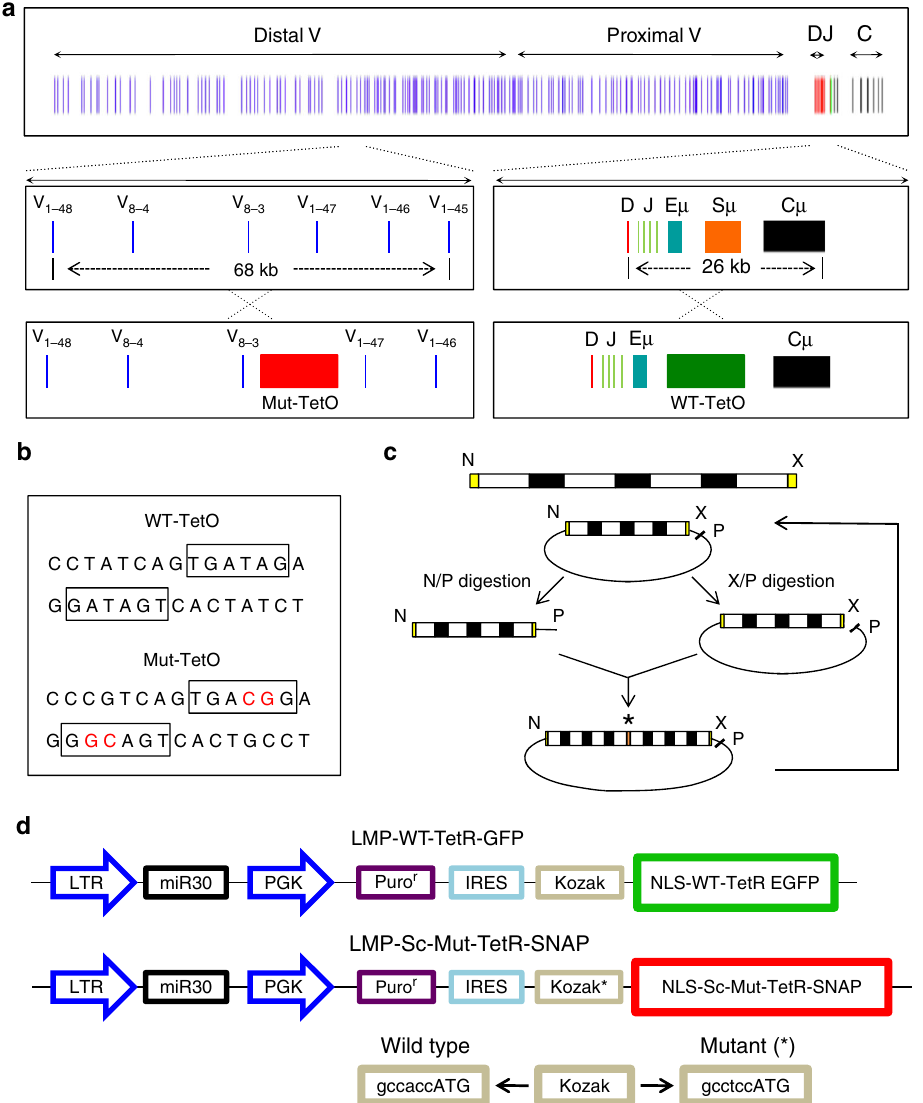
Fig. 1 A strategy for tracking V H -D H J H motion in live B cells. a Schematic diagram of the Igh locus showing V H , D H , J H , C H gene segments, intronic enhancer (E μ ), and switch region repeats (S μ ). b DNA sequences of wild-type and mutant TET operator binding sites. Nucleotides for which the mutant binding sites differ from that of WT-TET binding sites are indicated in red. c Tandem arrays containing 360 copies of the MUT-TET binding site were generated by sequential cloning and expansion as described previously 47 . Each template contained four MUT-TET binding sites (white boxes). Black boxes (N10) refer to a 10 bp oligonucleotide composed of random DNA sequences. N refers to Nhe 1, X to Xba 1, and P refers to Pst 1. Asterisk indicates the junction of Nhe 1- Xba 1 ligated DNA segments. d Construction of retroviral vectors to optimize the signal to noise ratio in pro-B cells transduced with virus expressing wild- type TET-EGFP and MUT-TET SNAP